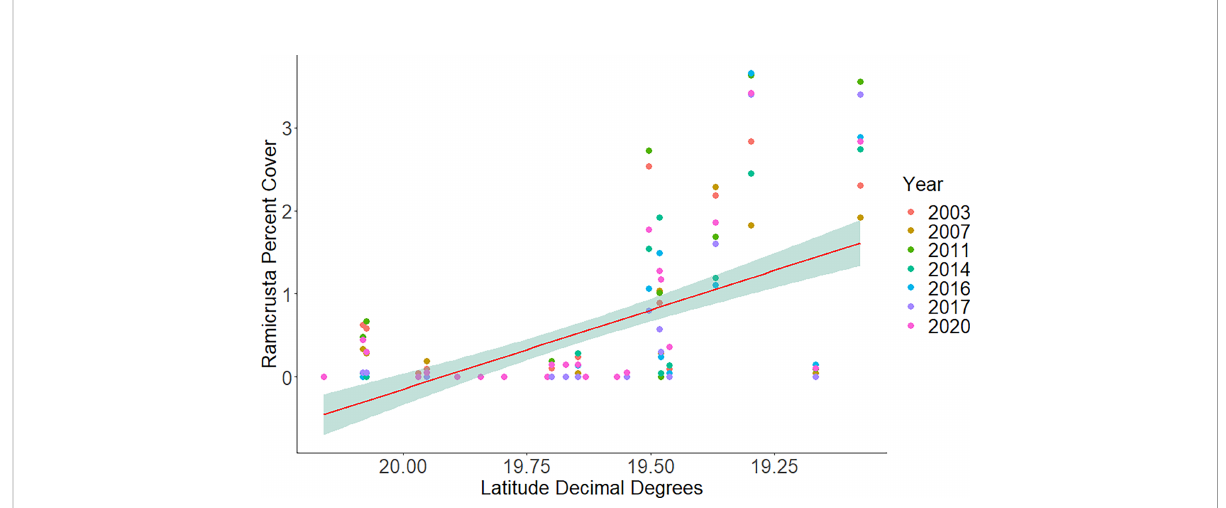
FIGURE 6 Average percent cover of Ramicrusta at DAR-WHAP sites from north to south in each year of surveying. Ramicrusta percent cover shows an abrupt increase at sites south of 19.60 latitude. Red line indicates the best fi t line with the shaded region showing the standard error.